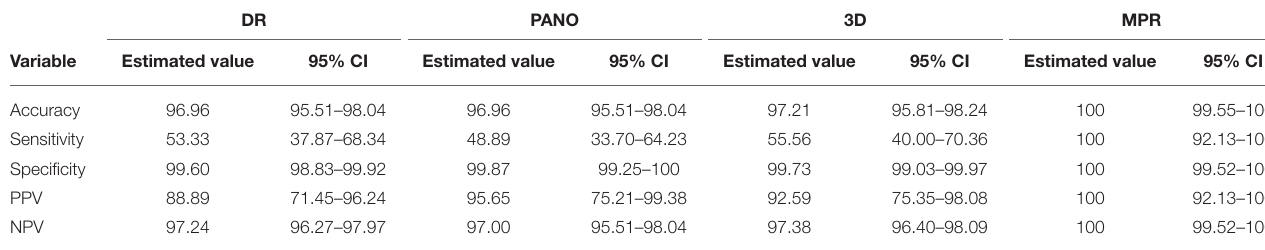
TABLE 8 | Ability to identify loss of tooth integrity in cats by use of dental radiography (DR method) and 3 CBCT software modules*.